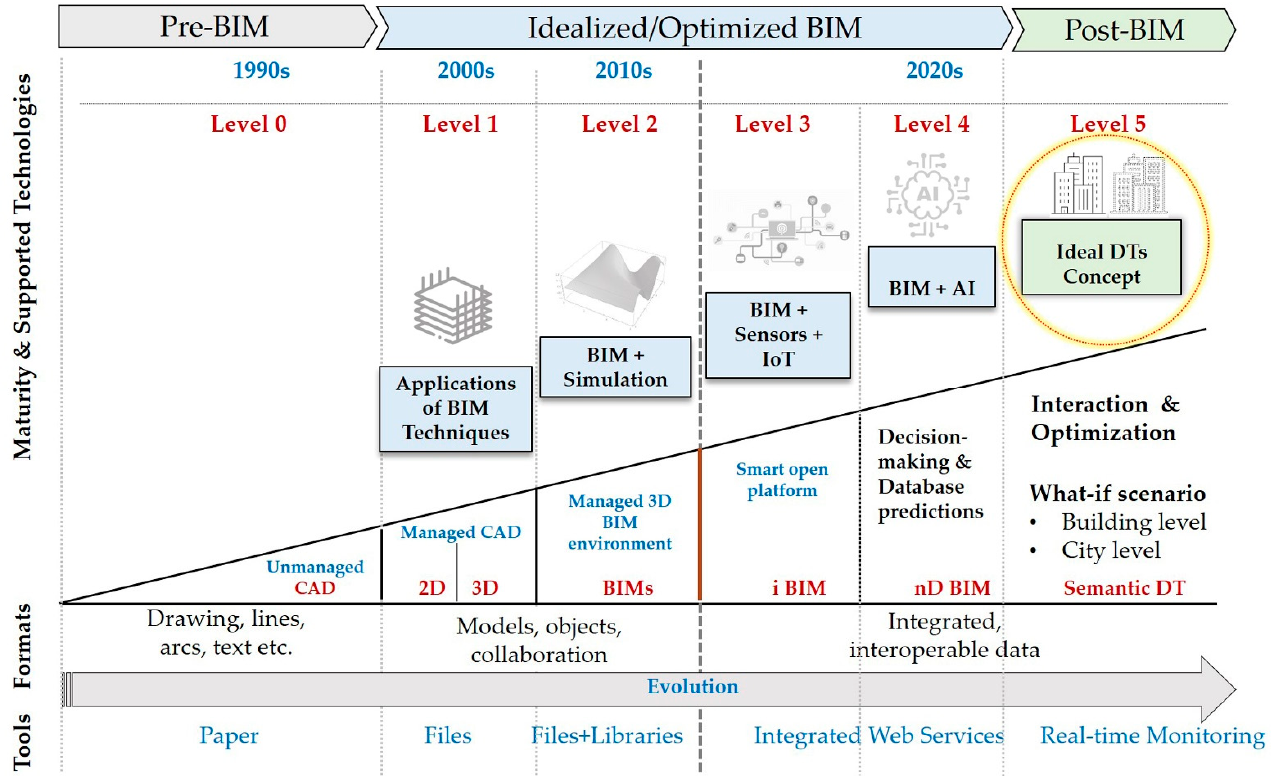
Figure 5. Five-level ladder taxonomy from BIM to DTs. Adapted from [6,60,64] .